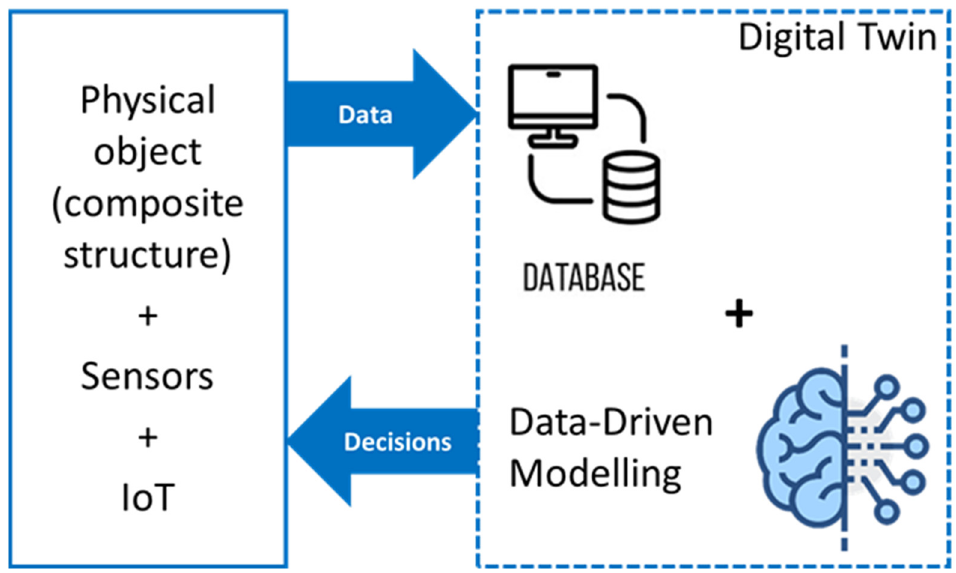
Figure 14. Main components for building digital twins for diagnosis of a physical object (ex. composite structure).